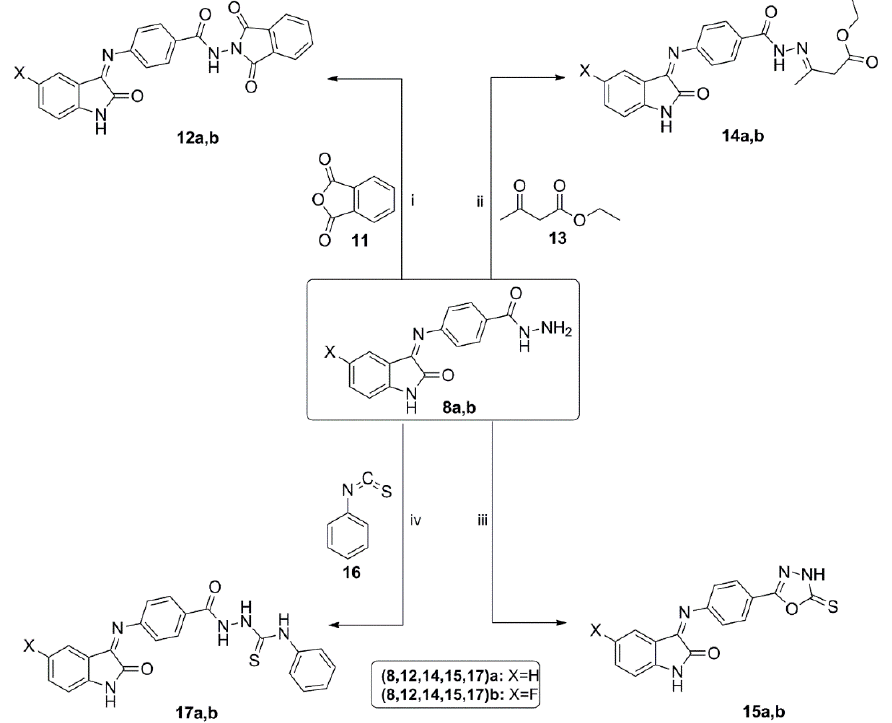
Scheme 3. Synthesis of the target compounds 12a , b – 17a , b . Reagent and conditions: ( i ) AcOH, soni- cation, 50 °C, 4 h; ( ii ) EtOH, AcOH, Reflux, 4 h; ( iii ) ( a ) CS 2 , KOH, EtOH, Reflux, 12 h, ( b ) 10% HCl; ( iv ) EtOH, Reflux, 8